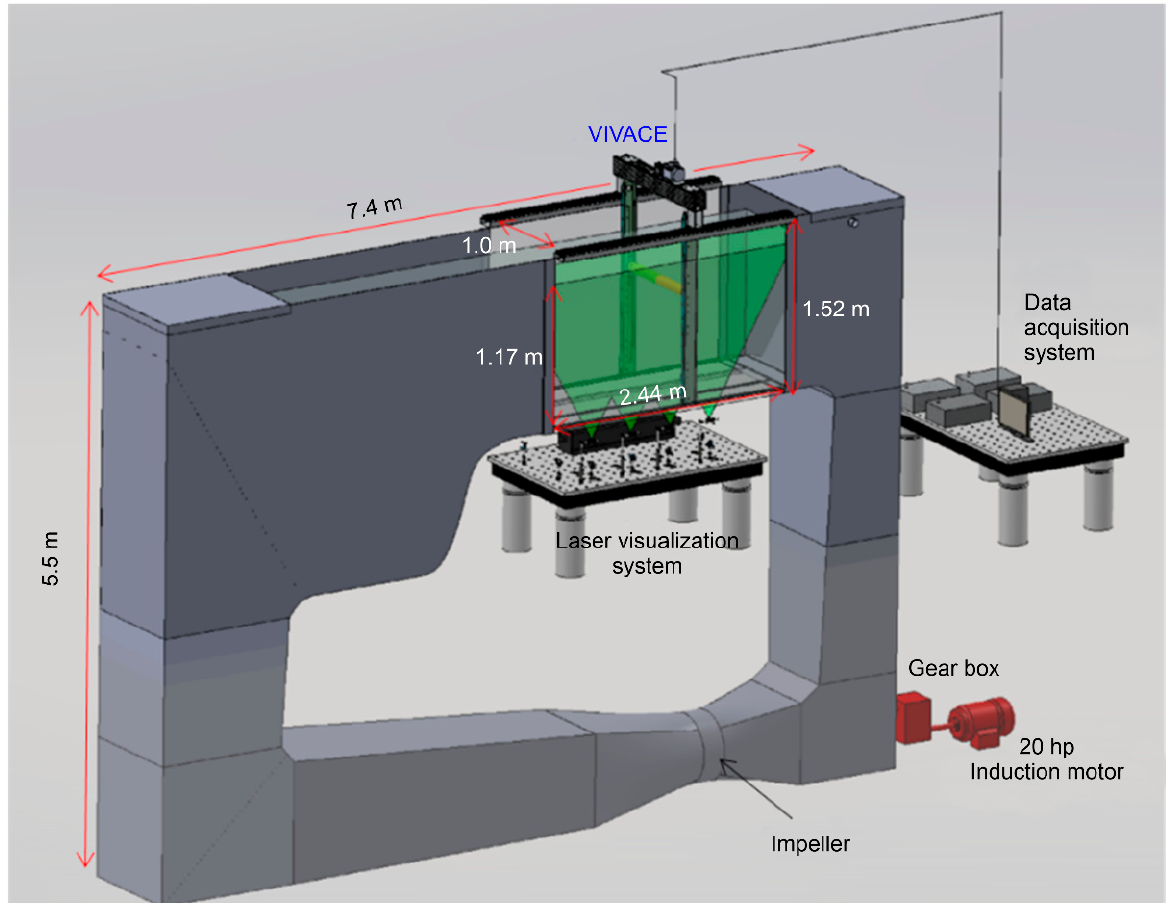
Figure 6. Schematic of the LTFSW channel and single cylinder converter [12]. The Reynolds number in the range of 30,000 < Re < 120,000 and the flow velocity in the range of 0.395 m/s < U < 1.315 m/s were the tested data conditions used in this study. When the mass ratio (m* = m osc /m d ) was 1.343, the spring constant (K) was 400, 600, 755, 1000, and 1200 N/m, and the harness damping ratio ( ζ harness ) for each spring constant was 0.04, 0.08, 0.12, 0.16, 0.2, and 0.24. Table 1 and Figure 7 show the results for the dynamic responses of a single rigid circular cylinder mounted with PTC [11,12,14]. In addition, the specifications of the single cylinder oscillator model, along with the tested conditions, are summarized in Table